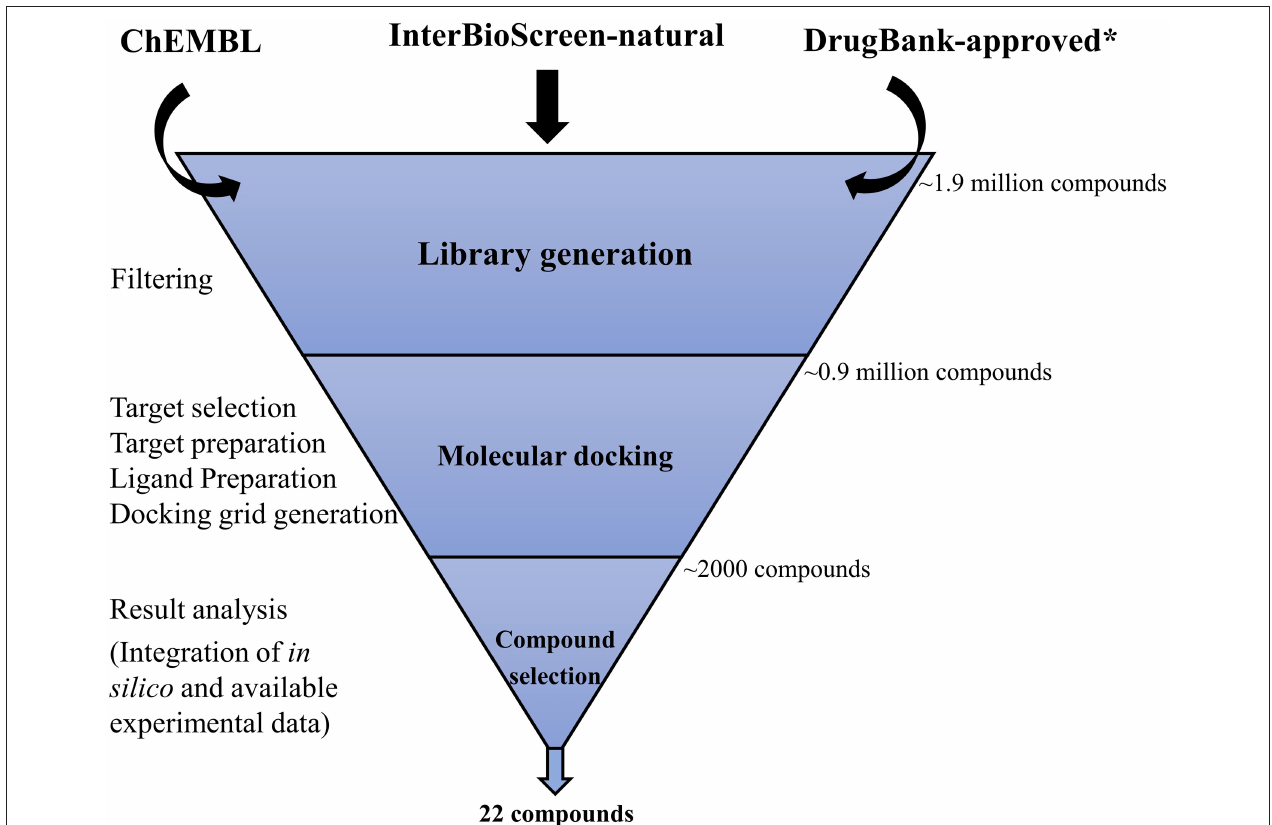
FIGURE 1 | Virtual screening workflow adopted in this study. Approximately 1.9 million compounds were collated from three different libraries (ChEMBL, InterBioScreen-natural, and DrugBank-approved). ChEMBl and InterBioScreen-natural compound libraries were subjected to filtering to discard molecules that are less likely to be good drug candidates. A clean library of ∼ 0.9 million compounds that includes the DrugBank-approved library was then subjected to hierarchical modes of docking simulations (HTVS, SP, XP). Nearly 2,000 hits obtained from this screening step were subjected to analyses to prioritize 22 promising compounds for further investigation as potential Mtb USP (Rv1636) binders. *The DrugBank-approved drugs library was not subjected to this filtering step as discussed in the